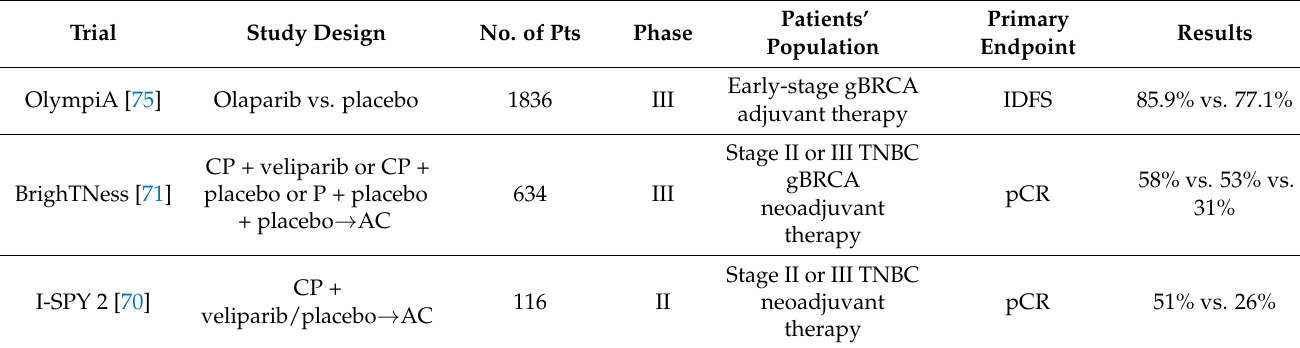
Table 2. Clinical trials with PARP inhibitors in the neoadjuvant/adjuvant treatment of BC.